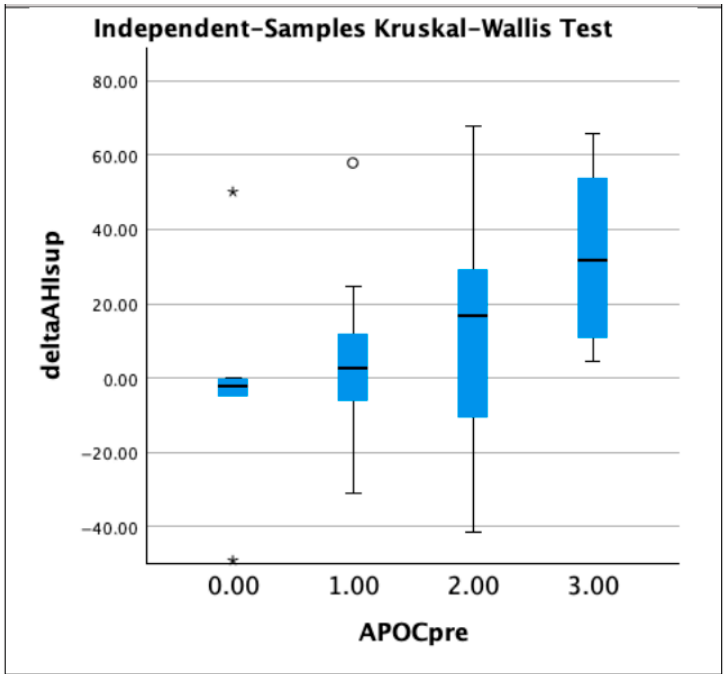
Figure 4. Boxplots showing delta AHI supine in patients divided in groups according to APOC classification (group 0 stands for non ‐ classifiable APOC; 1.00 = APOC 1, 2.00 = APOG 2, and 3.00 = APOC 3). Asterisks and circle represent outliers.